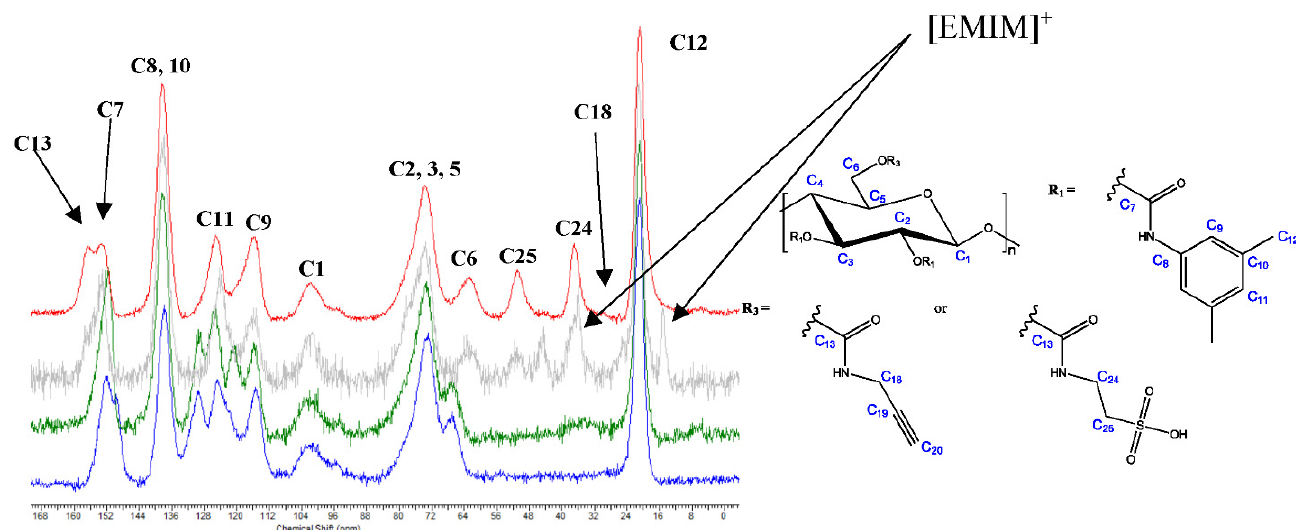
Figure 6. Solid-state 13 C NMR spectra of cellulose derivatives 13bD (grey = crude product, red = after purification) vs. 11c (green) and 11b (blue).